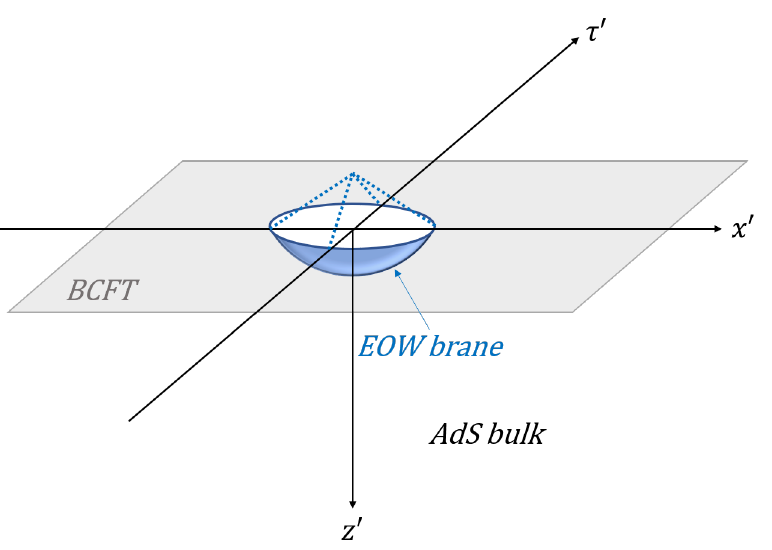
Figure 8. Holographic dual of the BCFT after the conformal transformation. The boundary of the BCFT is mapped to a circle and the EOW brane is mapped to a part of sphere.